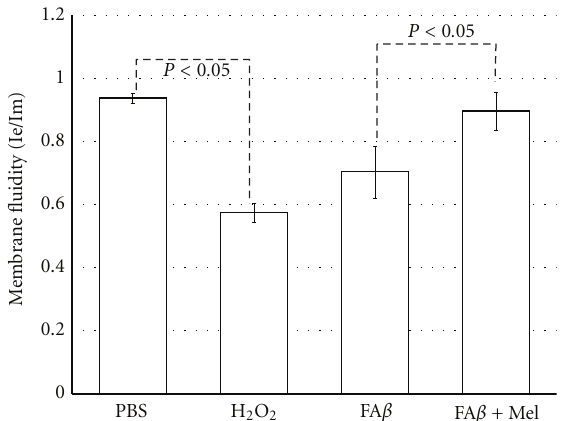
Figure 3: Brains of animals injected with A β showed a significant reduction in membrane fluidity as compared with PBS-injected brains, although less obvious than the observed in H 2 O 2 -injected brains, used as a positive control, which is in concordance with the degree of the free radicals overproduction, as shown in the previous graphic. Membrane fluidity in animals receiving melatonin was restored at the same level than the PBS